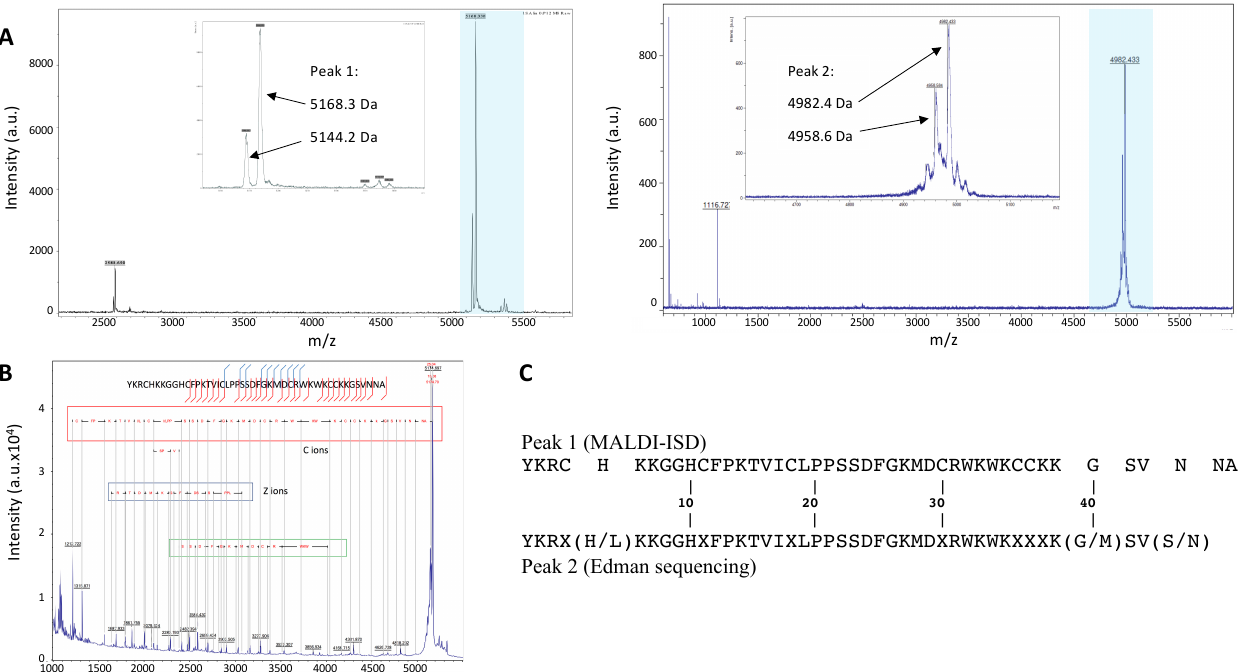
Figure 2. Mass spectrometry characterization and amino acid sequence determination. ( A ) Peptide masses values in peak 1 (left) and peak 2 (right) were determined by MALDI-TOF. The highlighted regions are widened in the insets. ( B ) The amino acid sequence of peptides from peak 1 was determined by ISD. ( C ) Alignment of the main peptide sequence of peak 1 (by MALDI-ISD) with that obtained by Edman degradation for peptides in peak